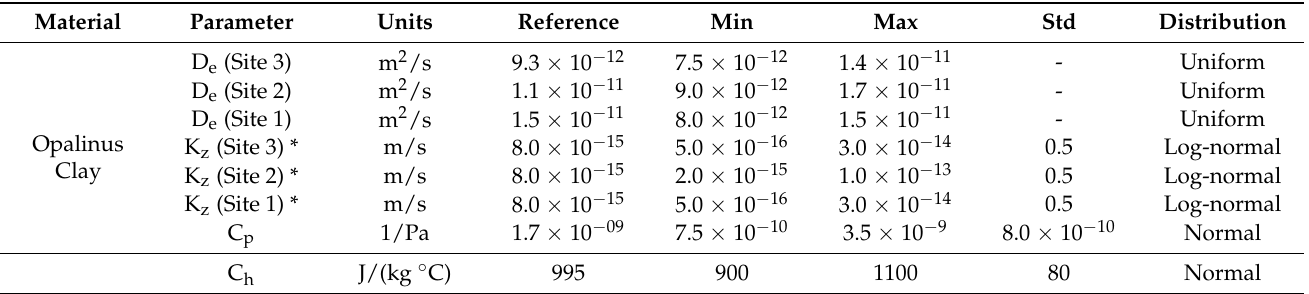
Table 1. Parameter ranges used in Monte Carlo simulations